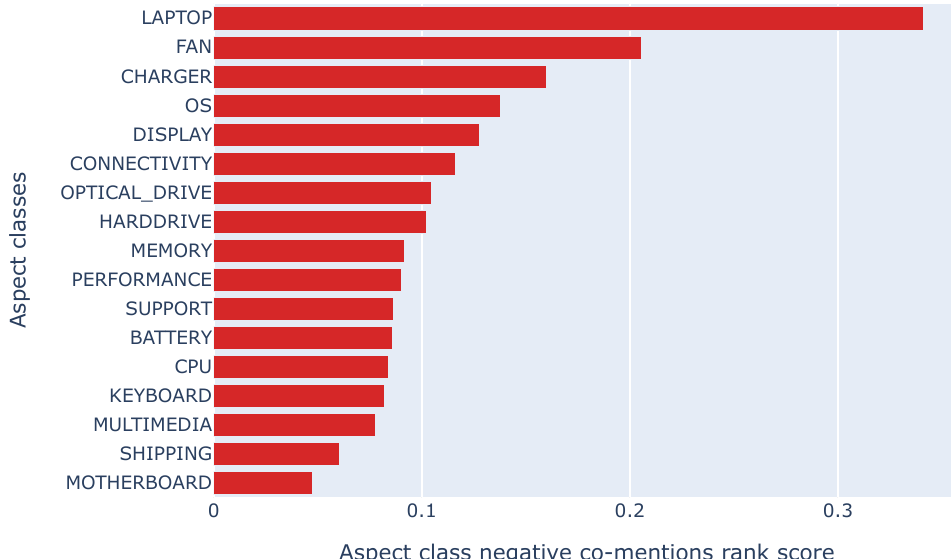
Figure 11. Product aspect class ranking for negative